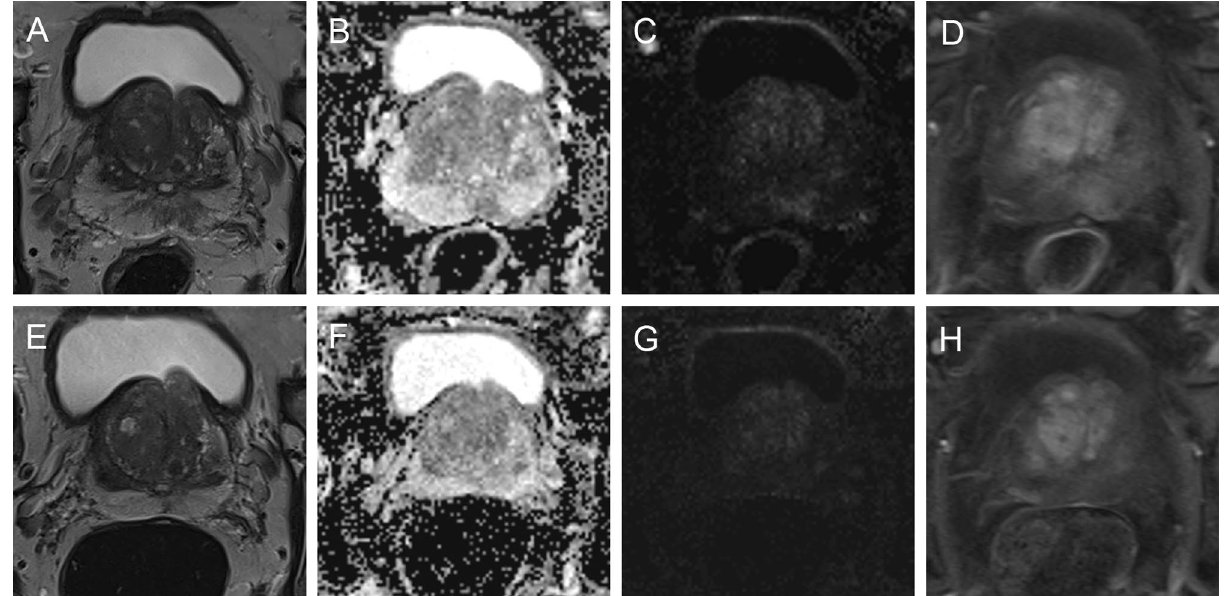
Figure 2. 64-year-old patient with rising PSA 12.2 ng/m. Initial MRI examination: Axial T2-weighted image ( A ) showed a non-circumscribed, rounded, moderate hypointensity in the left lateral peripheral zone with focal discrete hypointense ADC signal ( B ), focal discrete hyperintense signal on high b-value DWI ( C ) and discrete correlating contrast enhancement in DCE ( D ), assessed as PI-RADS category 3. Follow-up MRI after 38 months: Axial T2-weighted image ( E ) showed only residual changes, no ADC reduction ( F ), no more hyperintense signal on high b-value DWI ( G ), and no contrast enhancement ( H ). The PSA decreased (6.6 ng/ mL) and mpMRI was downgraded to PIRADS category 2.